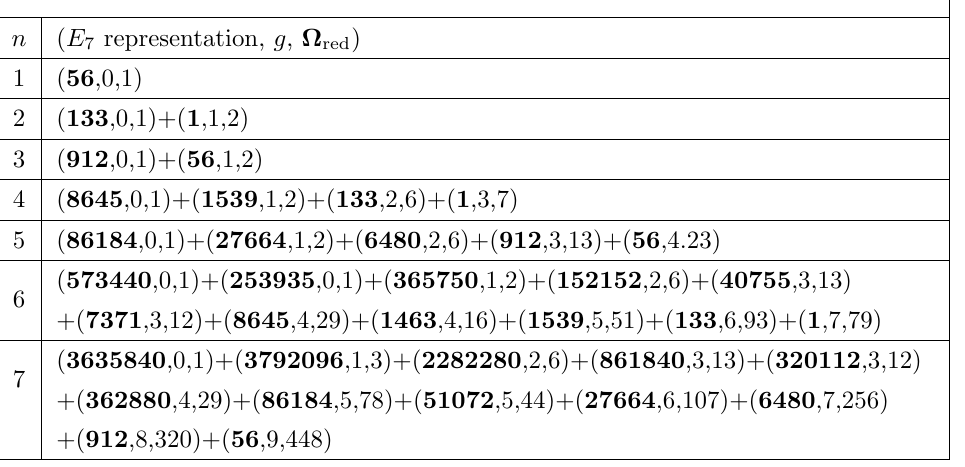
Table 3 . The allowed representations for BPS states with asymptotic charges n (1 ; 0), with 1 (cid:20) n (cid:20) 7 are listed. We also list the genus of the corresponding holomorphic curves, and the reduced index (cid:10) red computed in [38].